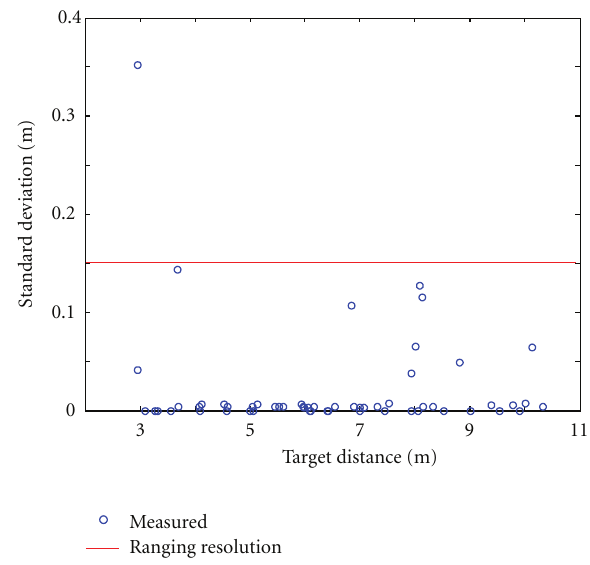
Figure 13: Standard deviation of ranging errors in outdoor